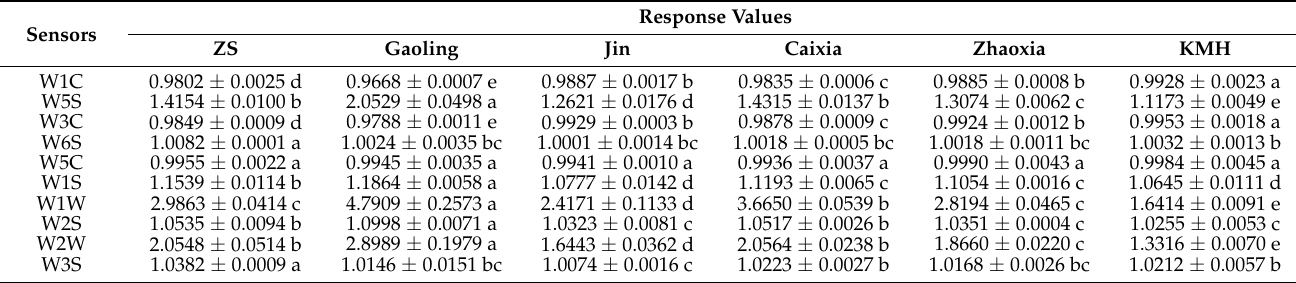
Table 2. Response values detected by ten E-nose sensors in different Hedychium accessions.